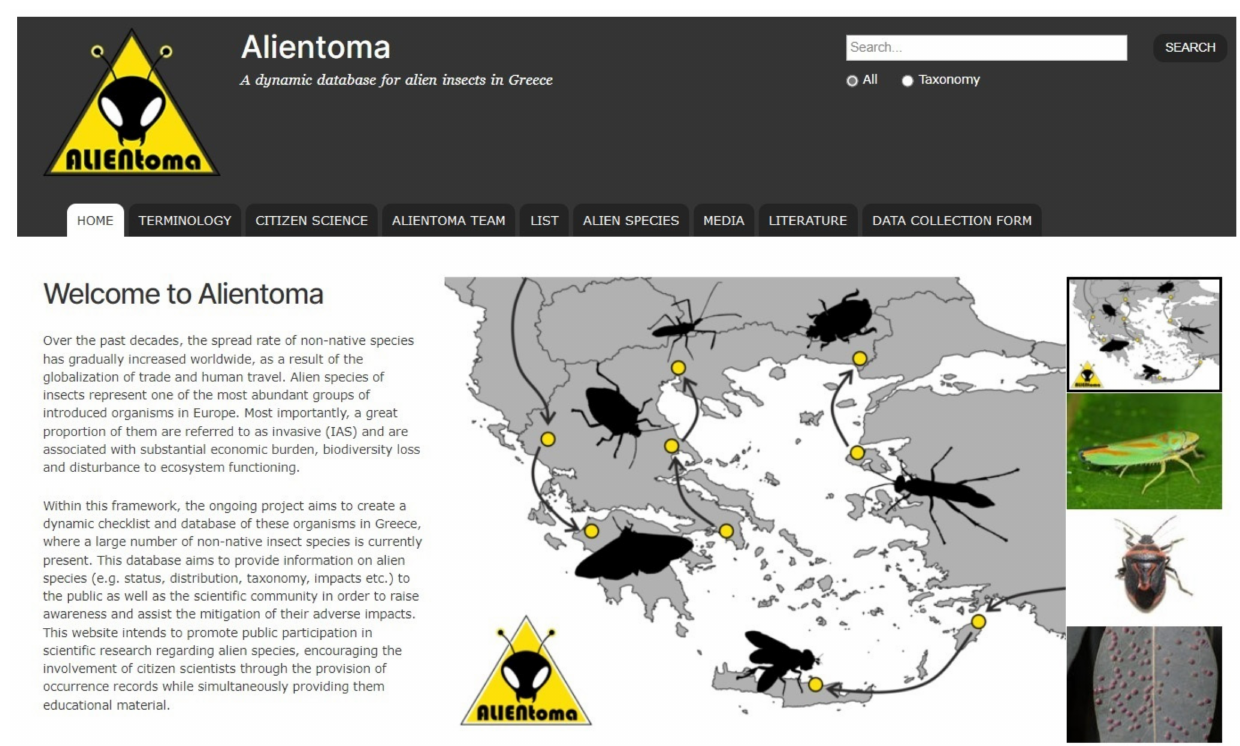
Figure 1. Main page of the Alientoma